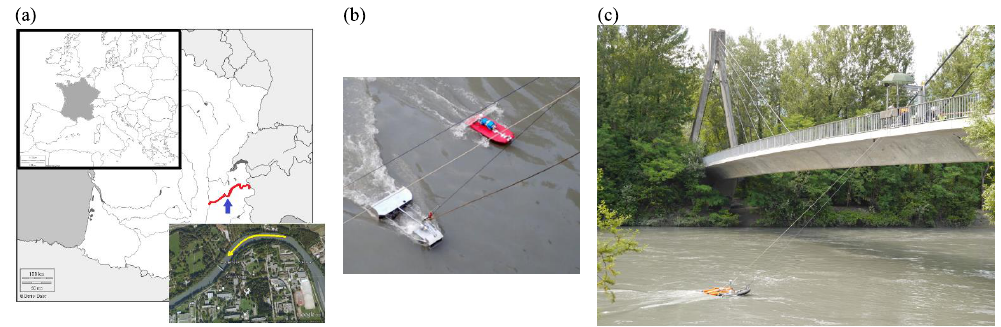
Figure 5. Experimental setup: (a) Isère River basin geographical location (http://histgeo.ac-aix-marseille.fr) and Google Earth© picture showing the river morphology near the bridge where measurements were taken; (b) instruments used during the trials; from left to right: Toutle TR sampler and the floating river-board with hydrophone; (c) the bridge from where acoustic drifts and sediment physical samplings were